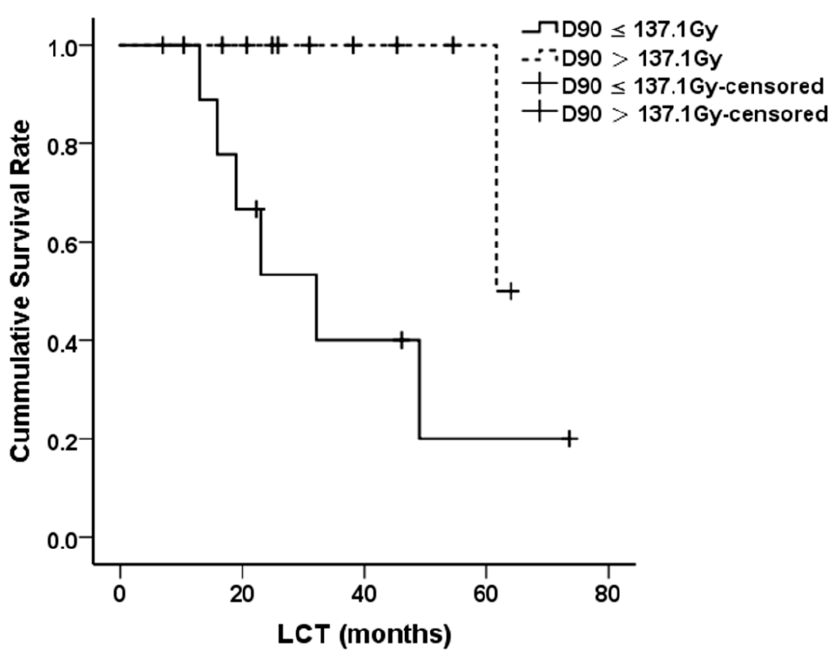
Figure 2. Local control time (LCT) of patients with different D90. Univariate analyses indicated no independent factors for OS in this case series (Table 3). Table 3. Univariate analyses for OS.